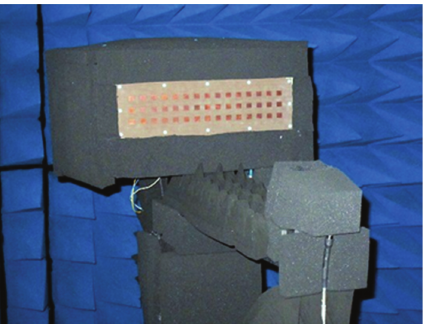
Figure 6: Photograph of the reflectarray prototype into the ane- choic chamber.